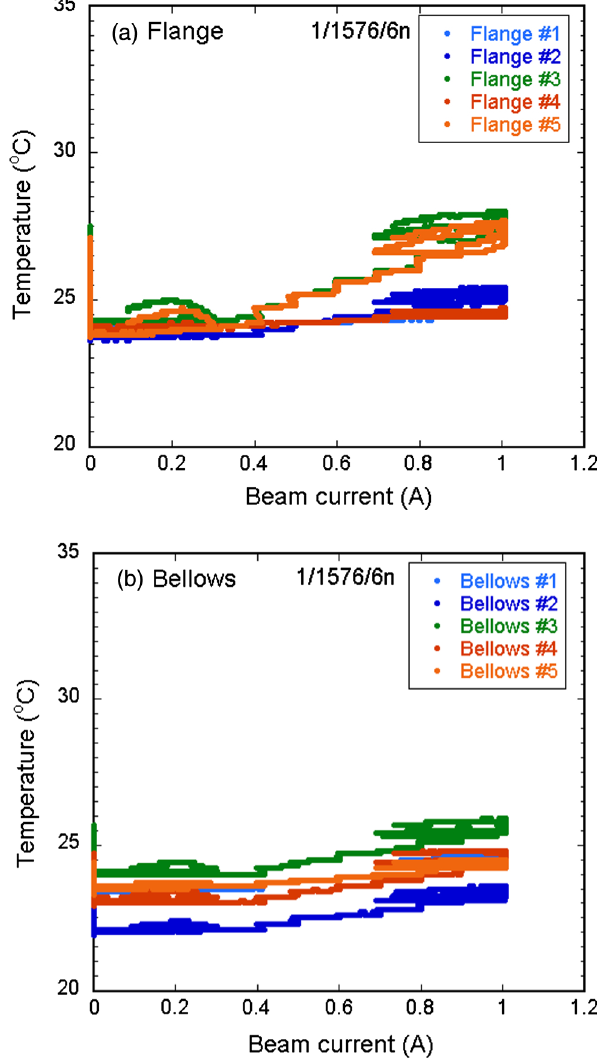
FIG. 6. Typical temperature changes (°C) of (a) five MO-type flanges and (b) five bellows chambers near the beam collimators versus the beam current (A), where the bunch fill pattern was 1 = 1576 = 6